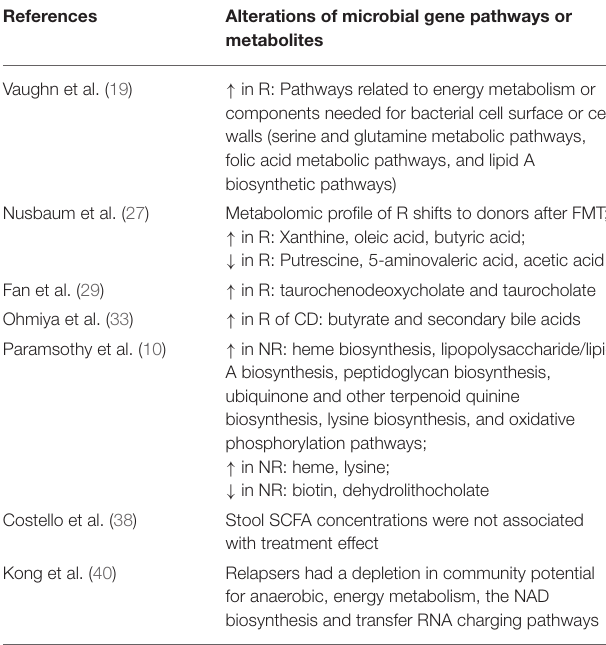
TABLE 6 | Alterations of microbial gene pathways or